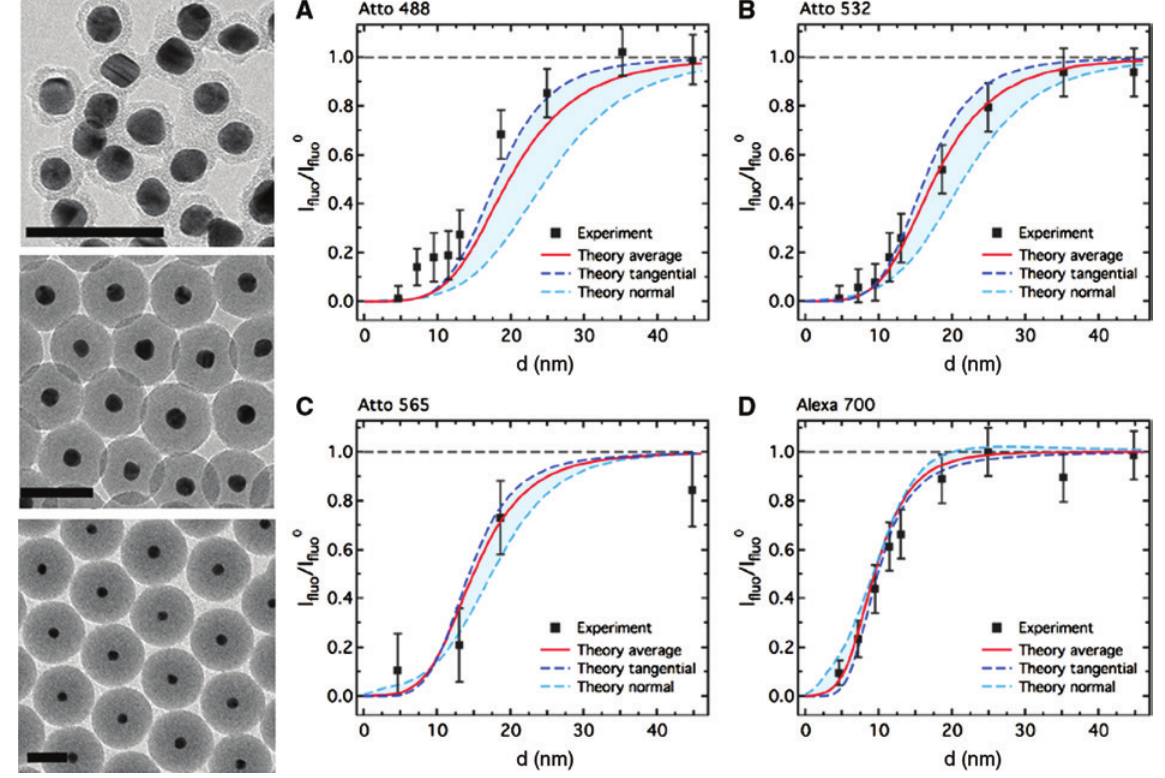
core-shell nanoparticles with 12.7 ± 0.3 nm Au cores and 3.6 ± 0.5 nm (up), 17.6 ± 0.7 nm (middle), and 34 ± 1.0 nm Figure 17: Left: Au@SiO 2 thick (down) silica shells. Scale bar in all images: 50 nm. Right: Experimental (black squares) and theoretical (solid and dashed lines) results for the relative fluorescence intensity as a function of the nanoparticle dye separation d. The fluorophores shown are Atto488 (A), Atto532 (B), Atto565 (C), and Alexa 700 (D). Adapted with permission from Ref. [136]. Copyright (2015) American Chemical Society.